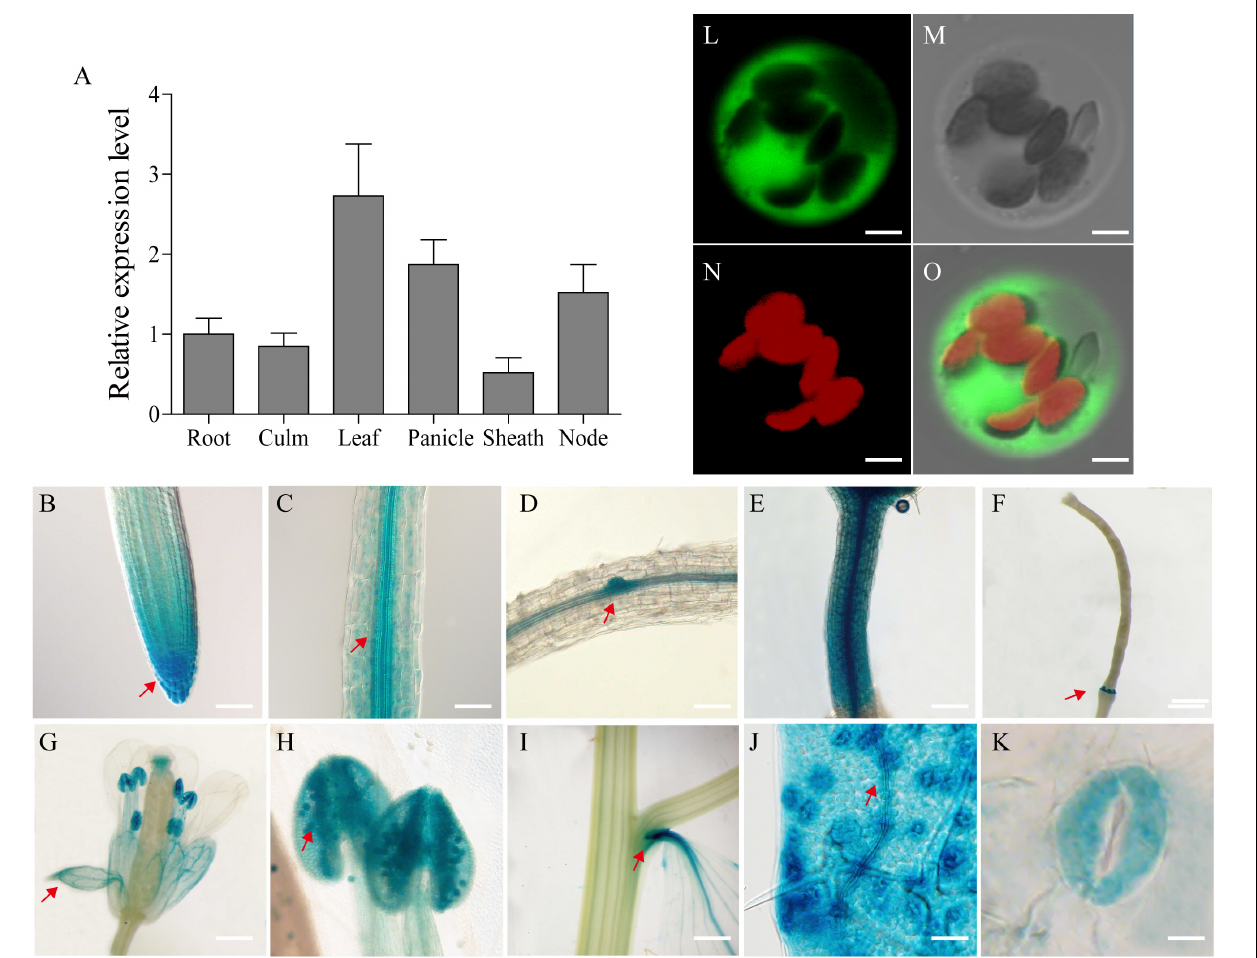
FIGURE 9 | Tissue-specific expression of the SiGRF1 gene and subcellular localization of its coding protein. (A) Analysis by RT-PCR of SiGRF1 expression patterns. SiActin was used as the control. (B–K) Root apical meristem (RAM), root cap columella, stele, lateral root primordium, hypocotyl, ripening siliques, sepals, pollen grains, petiole, mesophyll, and stoma. Scale bars = 500 µ m. (L–O) SiGRF1 localized to the cytoplasm. Green fluorescence indicates GFP and red fluorescence indicates stained protoplasts. Bars = 5 µ